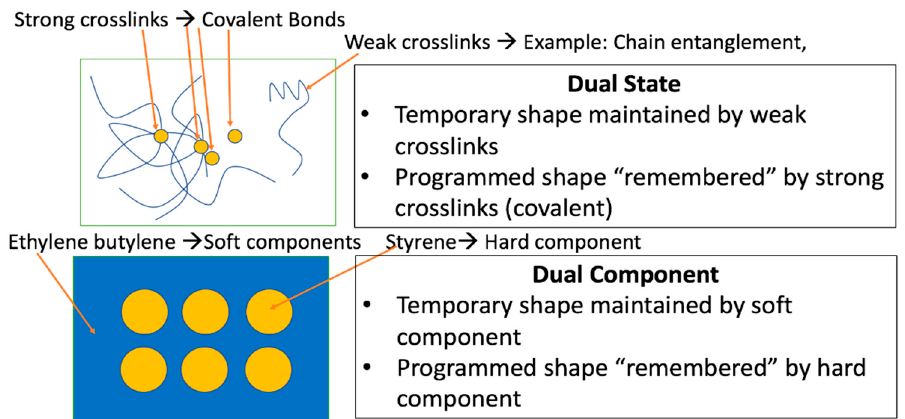
Figure 1. Depiction of the differences between dual state and dual component shape memory mechanisms. From [27].